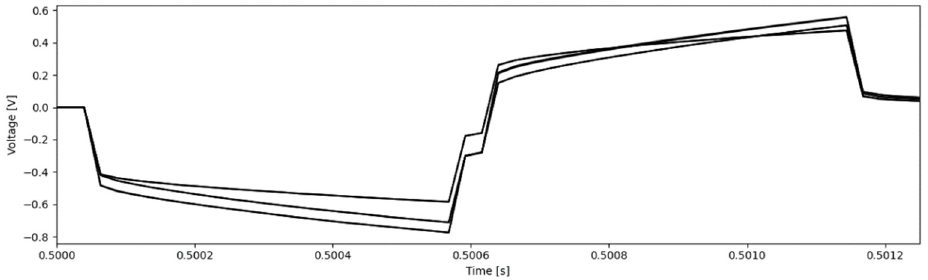
Figure 5. VT plot of one set of pulses at a charge density of 30 µC/cm 2 after short-term electro- chemical testing.